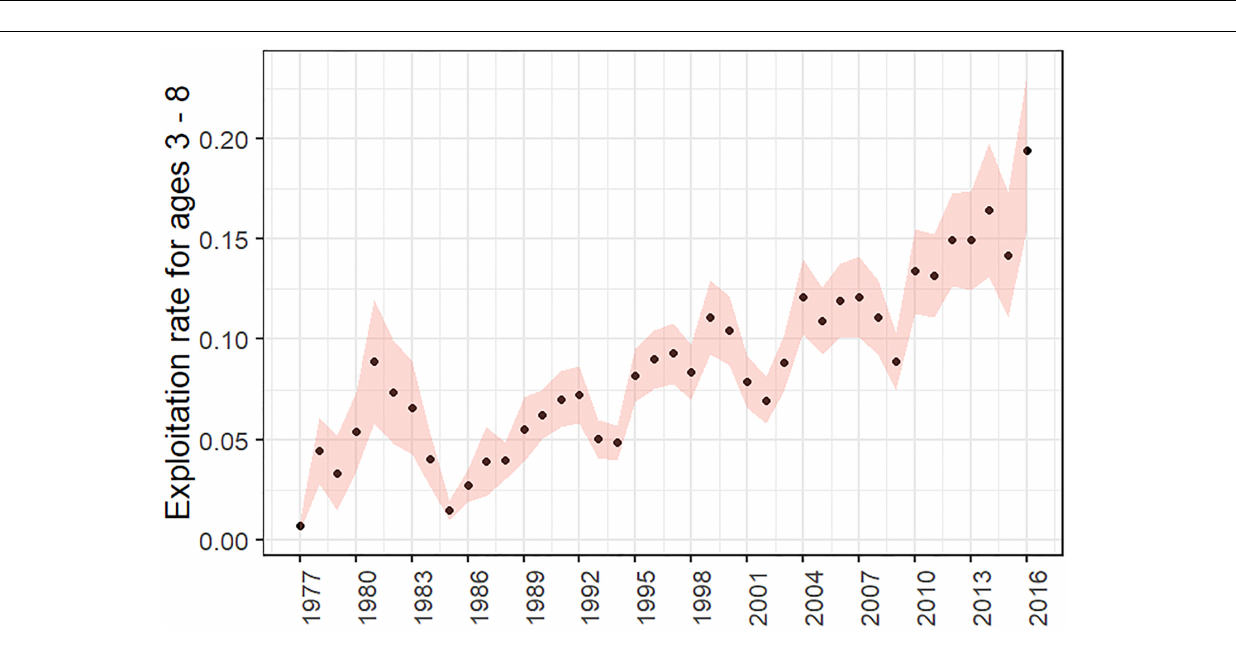
FIGURE 7 | Exploitation rates (F) of Gulf of Alaska Pacific cod age 3–8 with 95% confidence intervals for 1977–2016 (Barbeaux et al.,